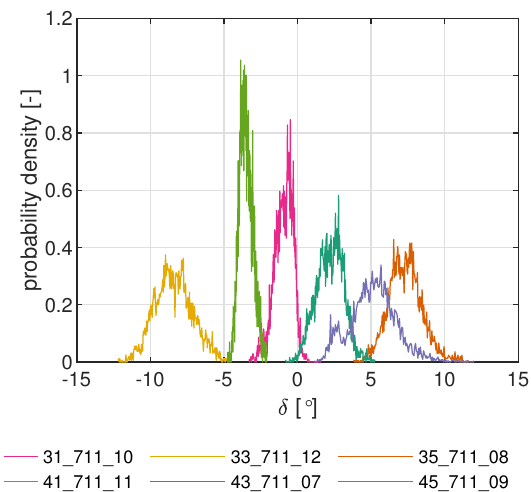
Figure 16: Probability density of deviation angle δ on panel 711 return strain rollers.